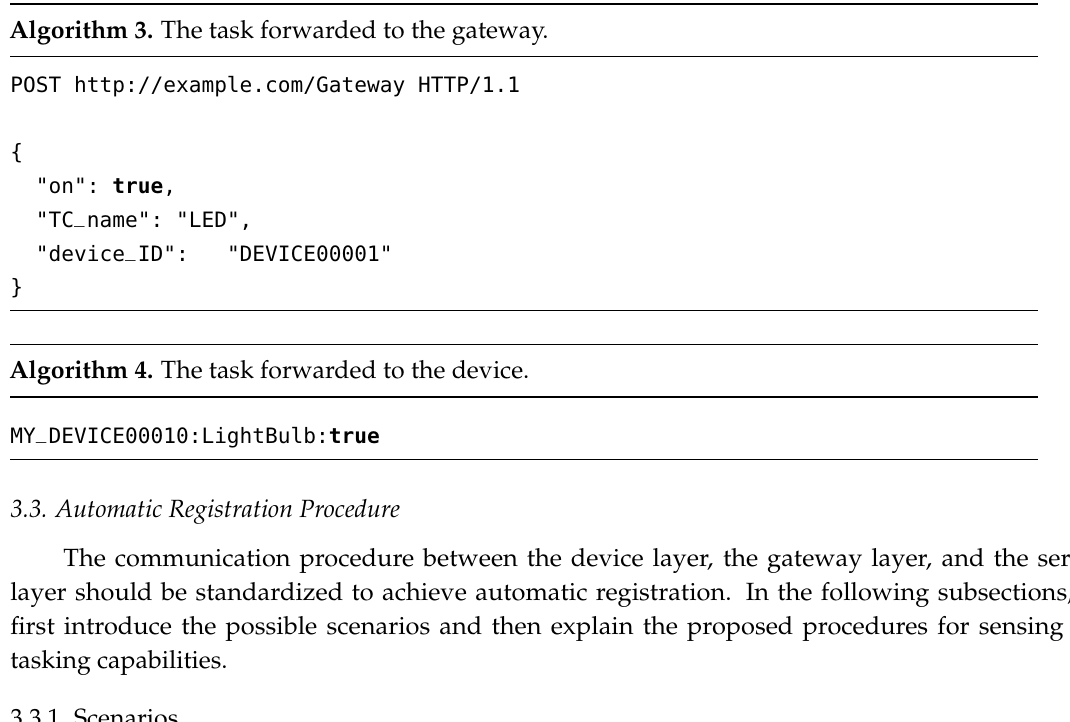
Algorithm 3. The task forwarded to the gateway.